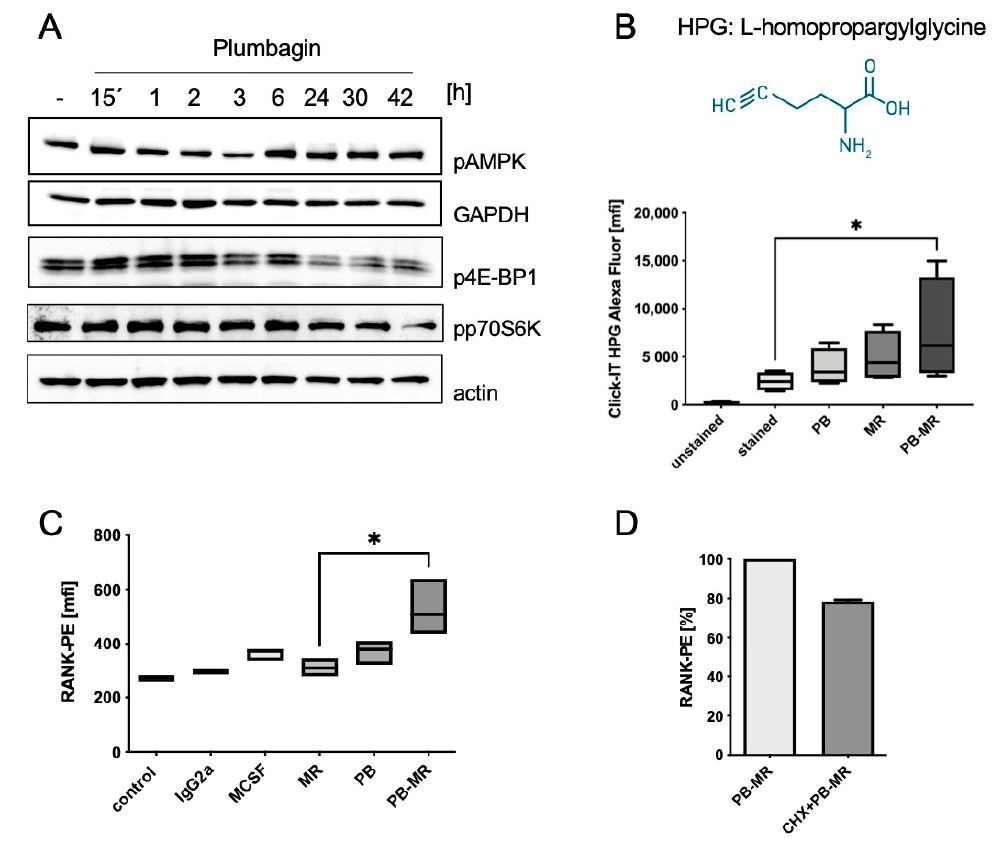
Figure 6. Plumbagin pre-treatment of BMDM facilitates osteoclastogenesis: ( A ) the expression of the metabolic signalling molecules pAMPK, p4E-BP1 and p70S6K was analysed from whole cell lysates at the indicated time-points of plumbagin stimulation. The blots show one typical example out of 3 experiments; ( B ) translational activity was measured using a Click-IT assay and the subsequent measurement of the incorporated, Alexa488 click-labelled HPG-containing proteins. Cells were treated for 6 h as indicated before chasing for 30 min with HPG. Untreated unstained and untreated stained cells were used as negative controls for background fluorescence and background translational activity, respectively. Fixed cells and Alexa488 were then measured by FACS analysis ( n = 4). Statistical analysis was performed by comparing results to the untreated control using a Friedman test; ( C ) RANK expression was measured by FACS analysis using a phycoerythrin (PE)-labelled antibody; ( D ) cells were pre-treated with plumbagin or 10 µ M cycloheximide to block protein translation ( n = 3). Statistical analysis was implemented by comparing the results to the positive control (M-CSF/RANKL) using Kruskal–Wallis test. * p >